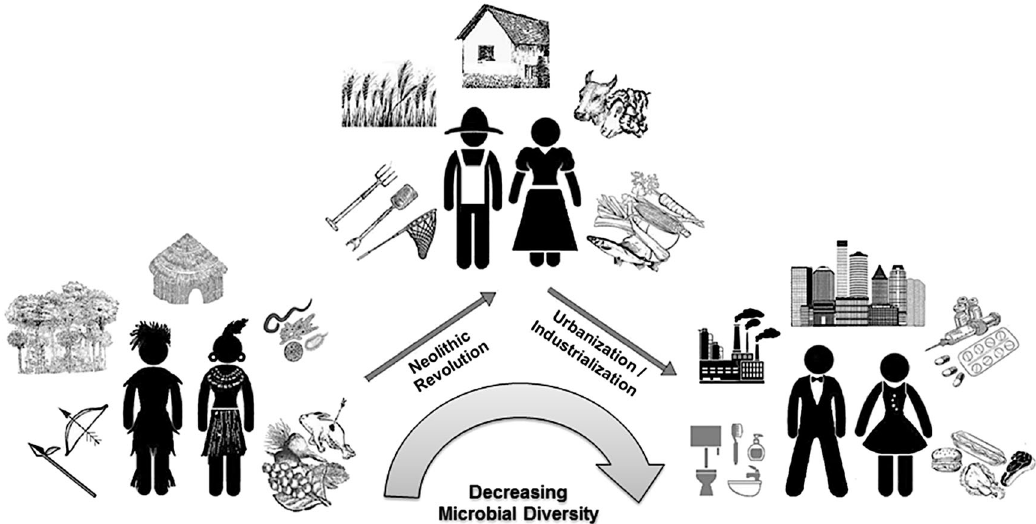
Fig. 1 Representation of human populations ’ transition from primitive to urbanized. The fi gure states that a cultural change from foraging and rural farming to urbanization and industrialization goes along with a decrease in microbial diversity (Gupta et al.,